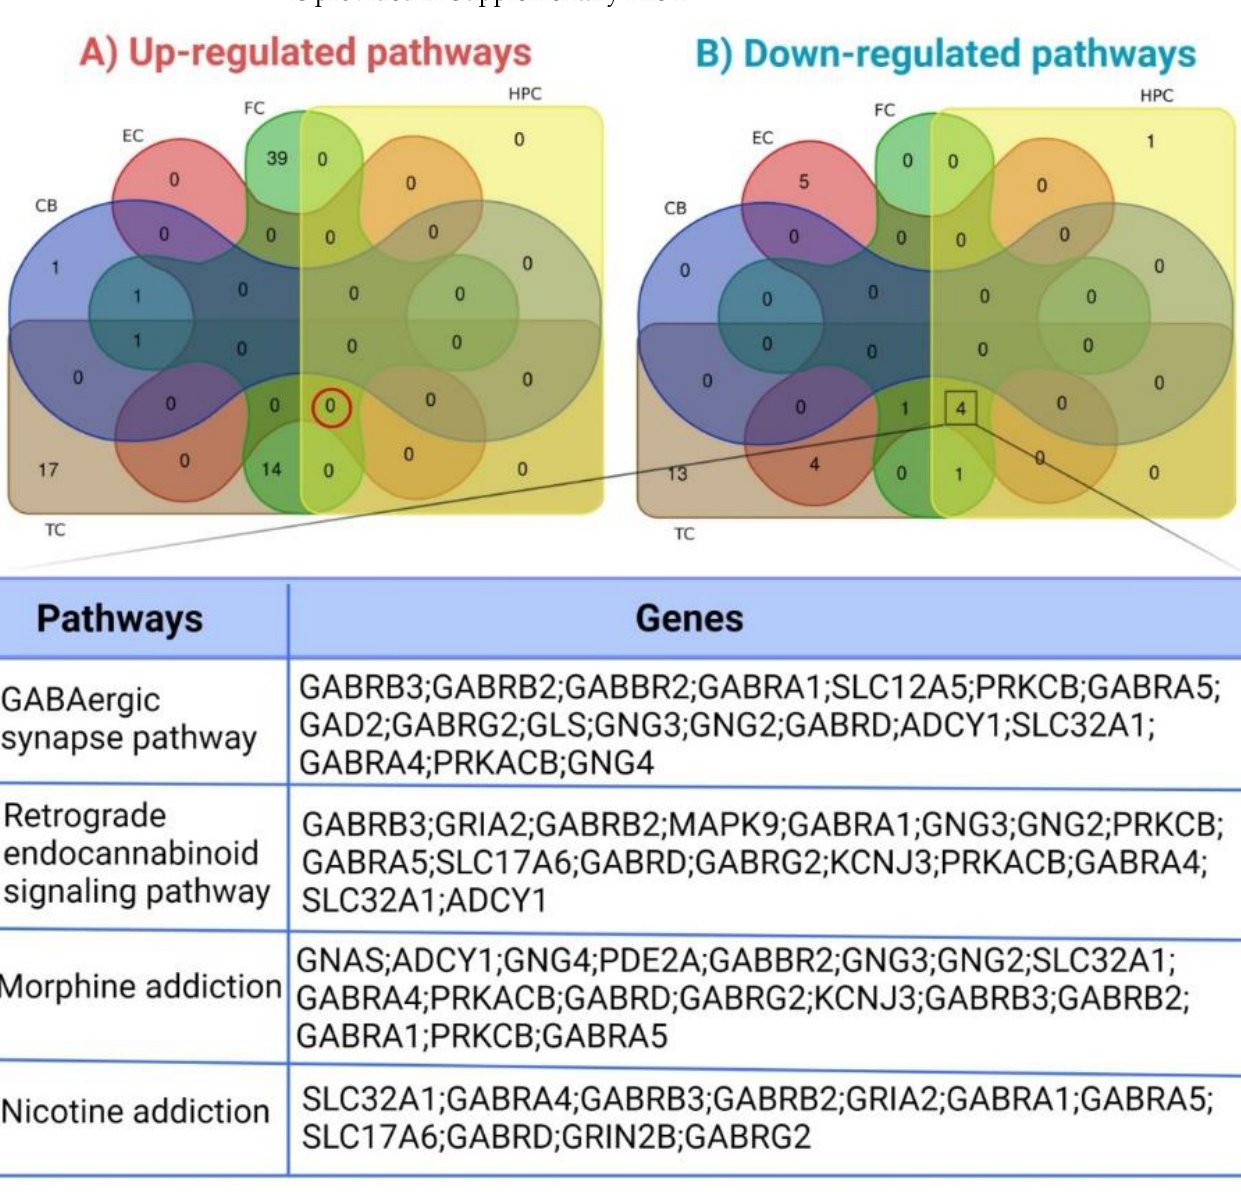
Figure 2. Venn diagram of KEGG pathway enrichment analysis on ( A ) Up-regulated and ( B ) Down-regulated pathways based on adjusted p -value. TC, temporal cortex; FC, frontal cortex; EC, entorhinal cortex; HPC, hippocampus; CB, cerebellum. Table 2. The top three enriched pathways by robust DEGs in each brain region, determined using Enrichr and KEGG.